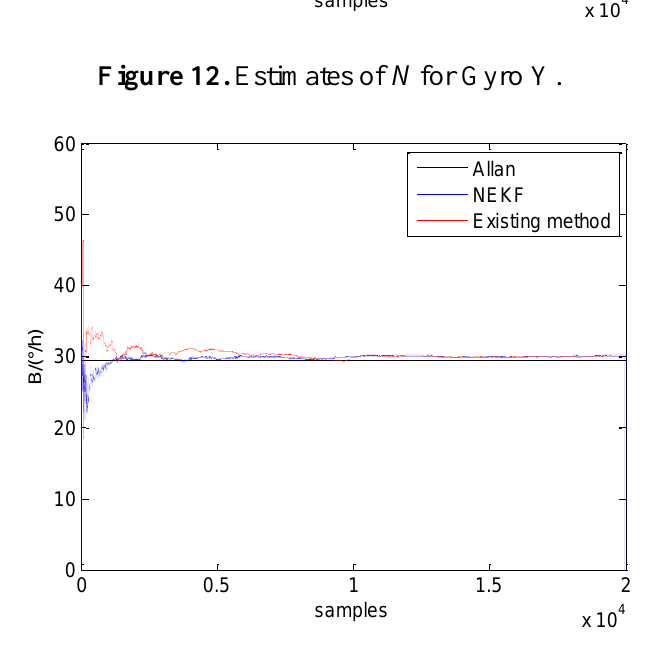
Figure 12. Estimates of N for Gyro Y.